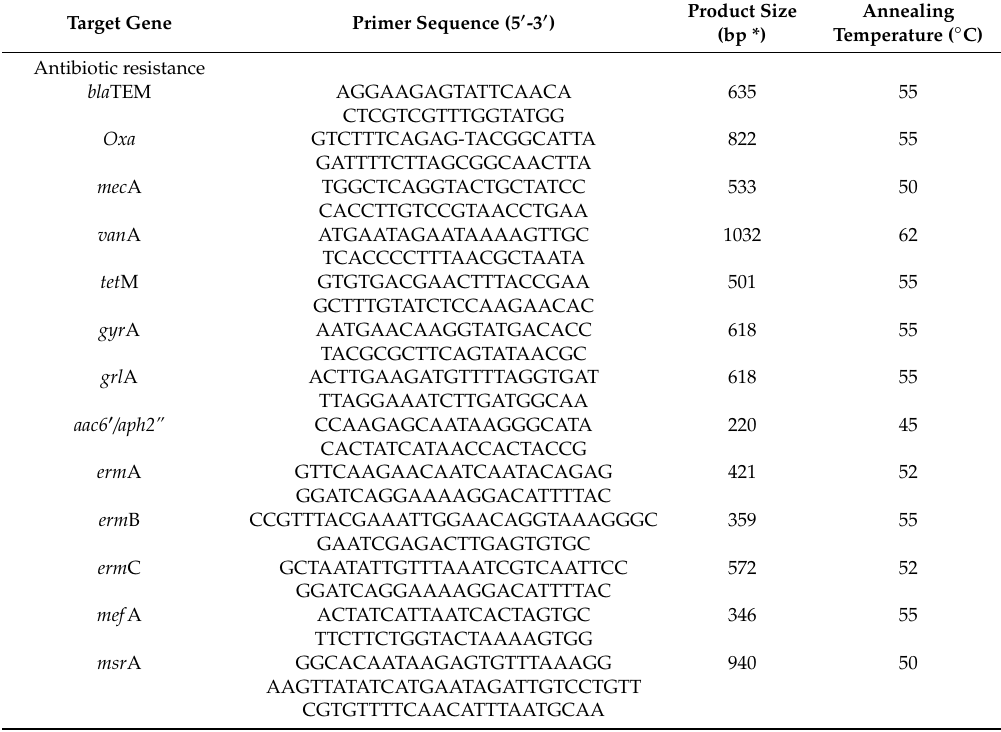
Table 1. Primers used for detection of genes assayed in this